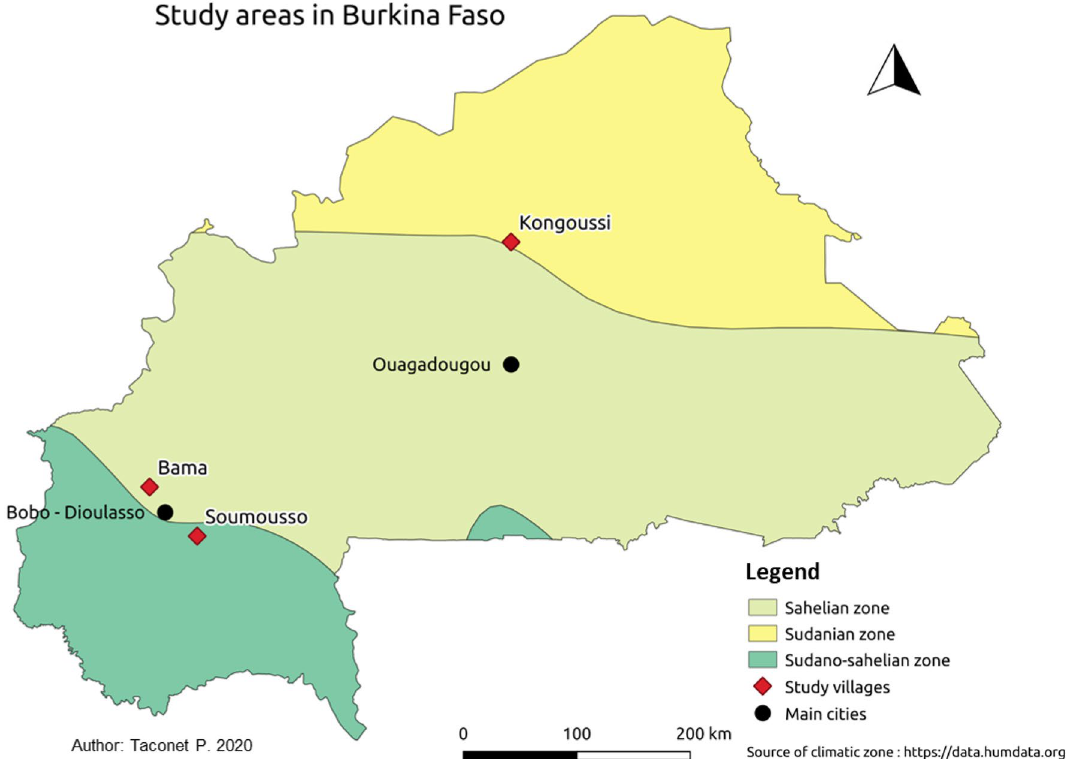
Figure 4. Location of collection points in Burkina Faso. The map includes the villages of the study with their climatic zones. Background of the map was produced with open data from openstreetmap.org. Data of climatic zones are obtained through: https:// data. humda ta.